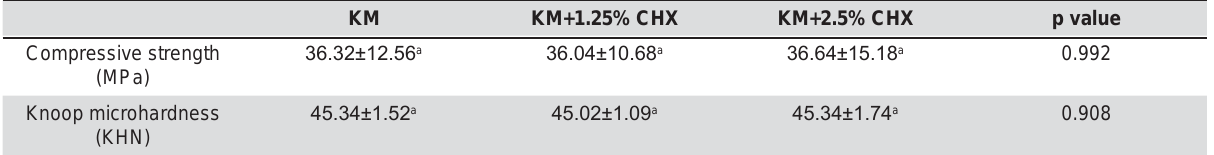
a The same lower letters indicate no statistical difference among the groups of materials, according ANOVA